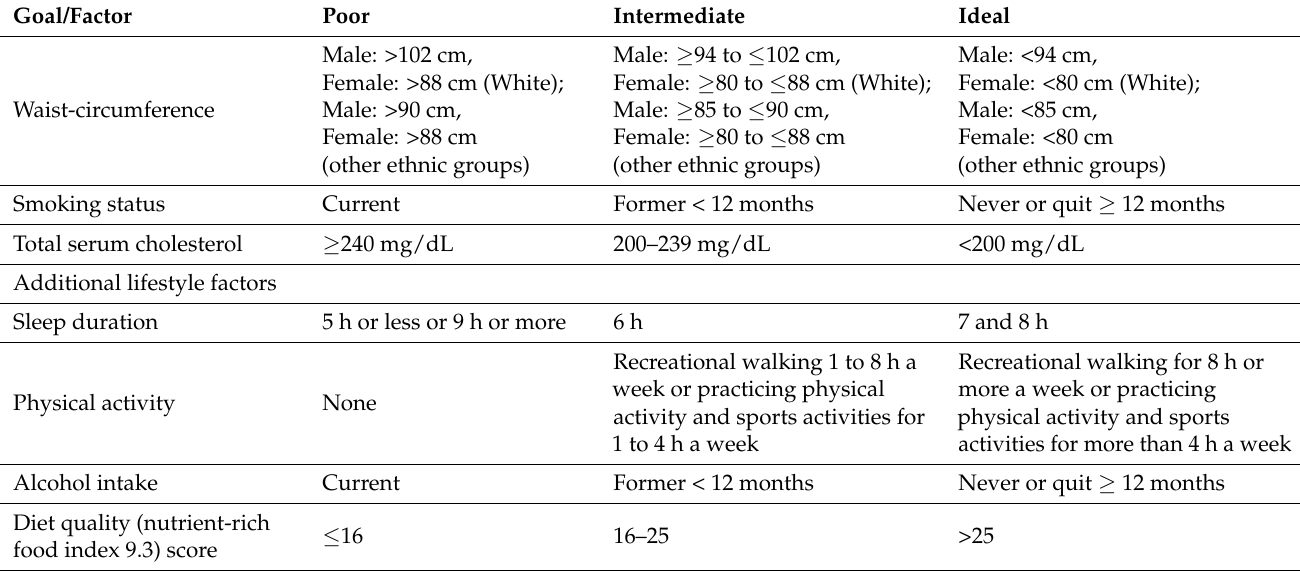
Table 1. Definition of poor, intermediate, and ideal BP lifestyle scores for each